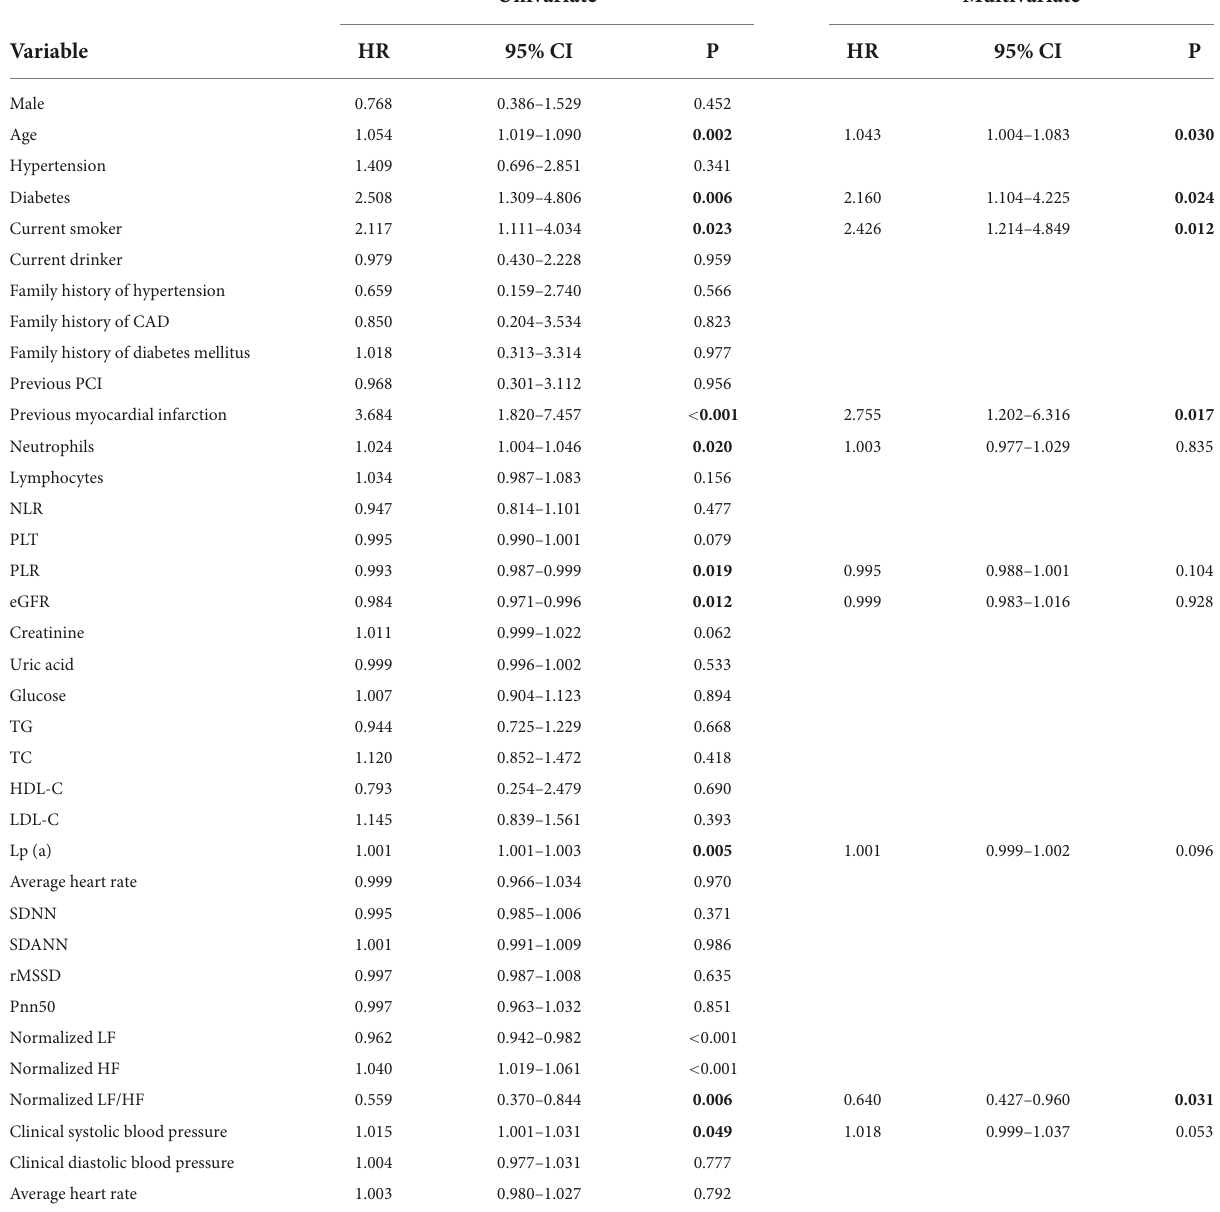
TABLE 2 Univariate and multivariable Cox regression analysis of factors associated with MACEs in the development cohort. Univariate